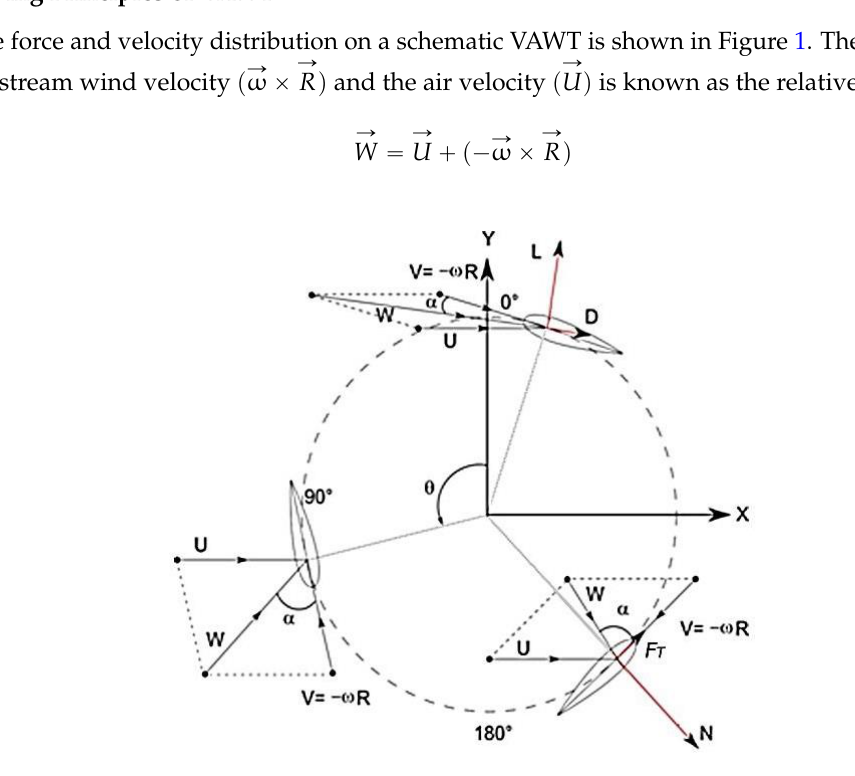
Figure 1. Force and velocity distribution on a vertical axis wind turbines (VAWT) [25]